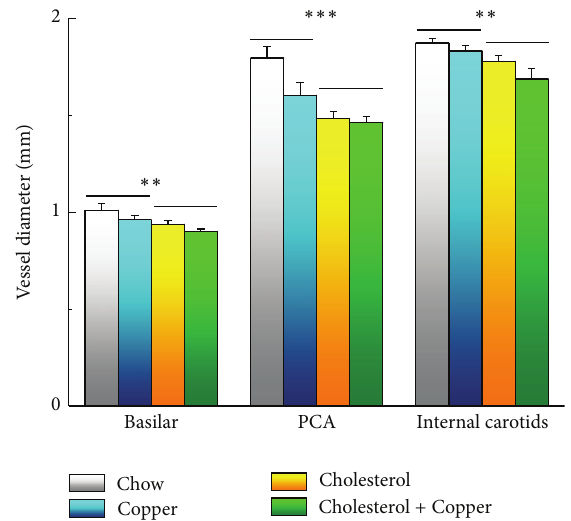
Figure 6: Mean ( ± SEM) vessel diameter of the left and right internal carotid arteries, basilar artery, and left and right posterior communicating arteries (PCA) for rabbits fed normal chow and given distilled drinking water (Chow), 2% cholesterol in their rabbit chow and given distilled drinking water (Cholesterol), fed normal chow and given 0.12 parts per million copper as copper sulfate in their distilled drinking water (Copper), or fed 2% cholesterol and given 0.12 parts per million copper in their distilled drinking water (Cholesterol + Copper). Data are modified from